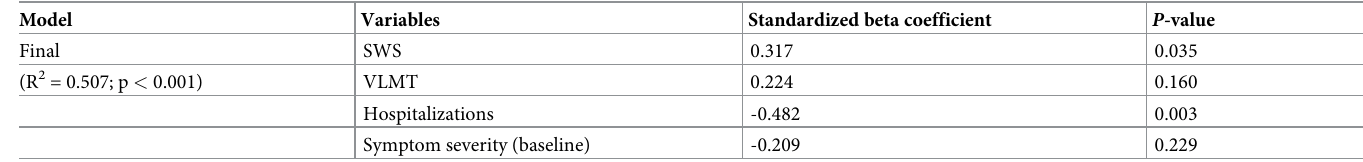
Table 3. Final multiple regression model using follow-up social functioning as the dependent variable.